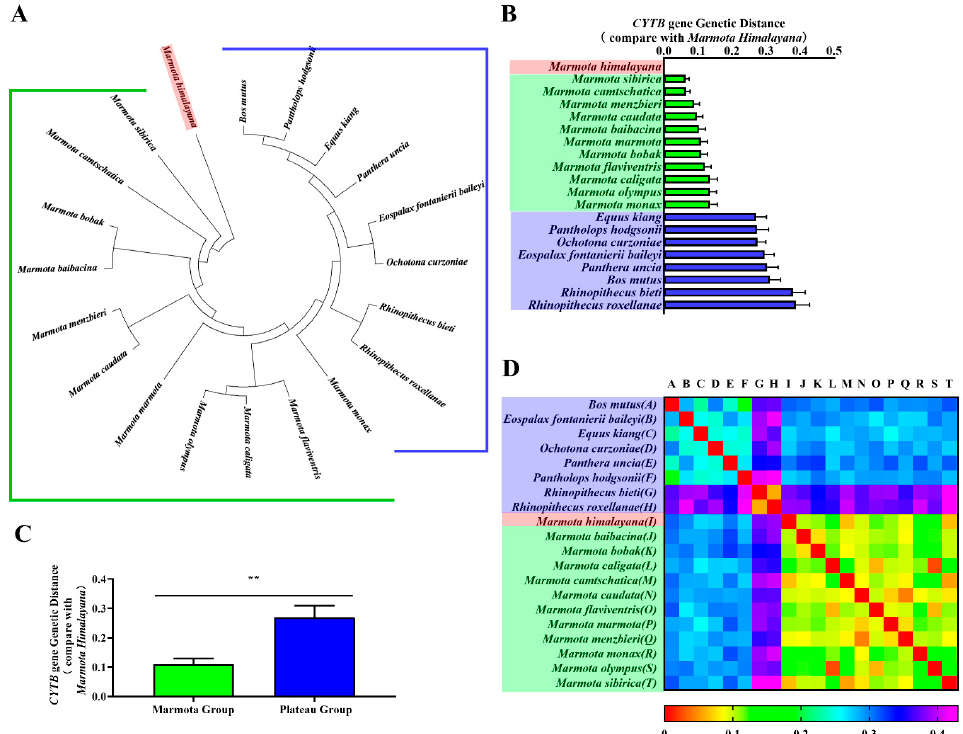
Figure 2. Phylogenetic analyses of CYTB gene. Phylogenetic trees for the CYTB gene were constructed in MEGA ( A ). The genetic distance from the Himalayan marmot to each member of the marmot group and the plateau group are represented as a bar chart ( B ). One-way ANOVA showed a significant difference (** p < 0.01) between the groups ( C ). A heatmap represents the correlation coefficients of the CYTB gene genetic distance for all species ( D ).